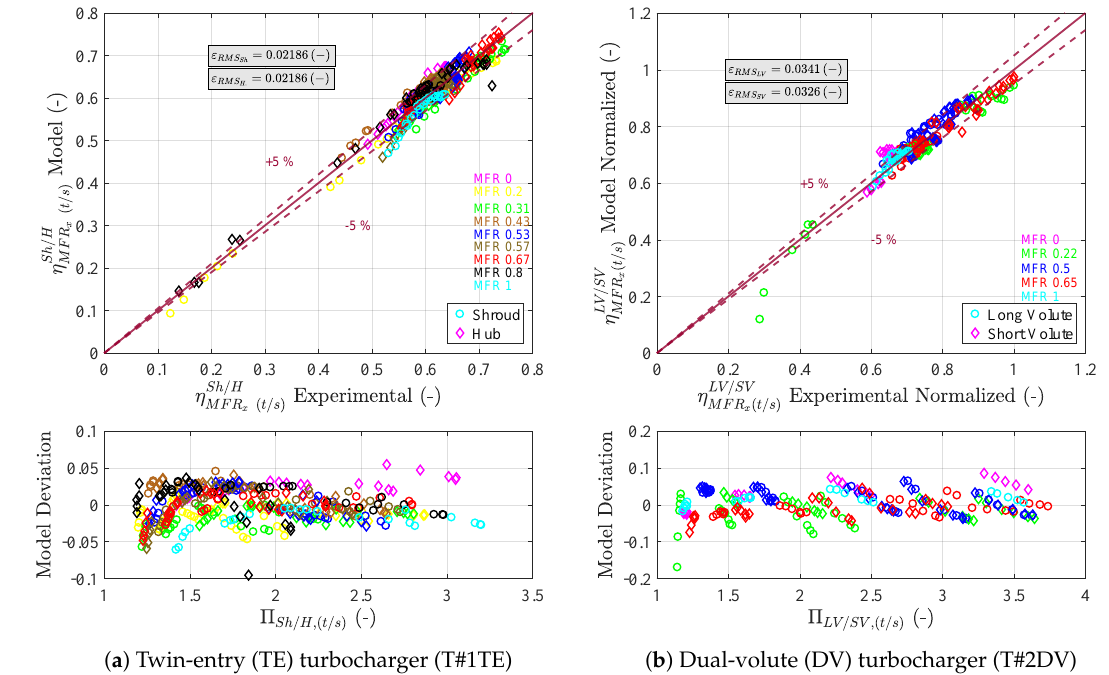
Figure 24. Turbine apparent efficiency Modeled versus Experimental for both T#1TE and T#2DV turbochargers. Model constants are found using all the MFR data points of both branches together for that particular